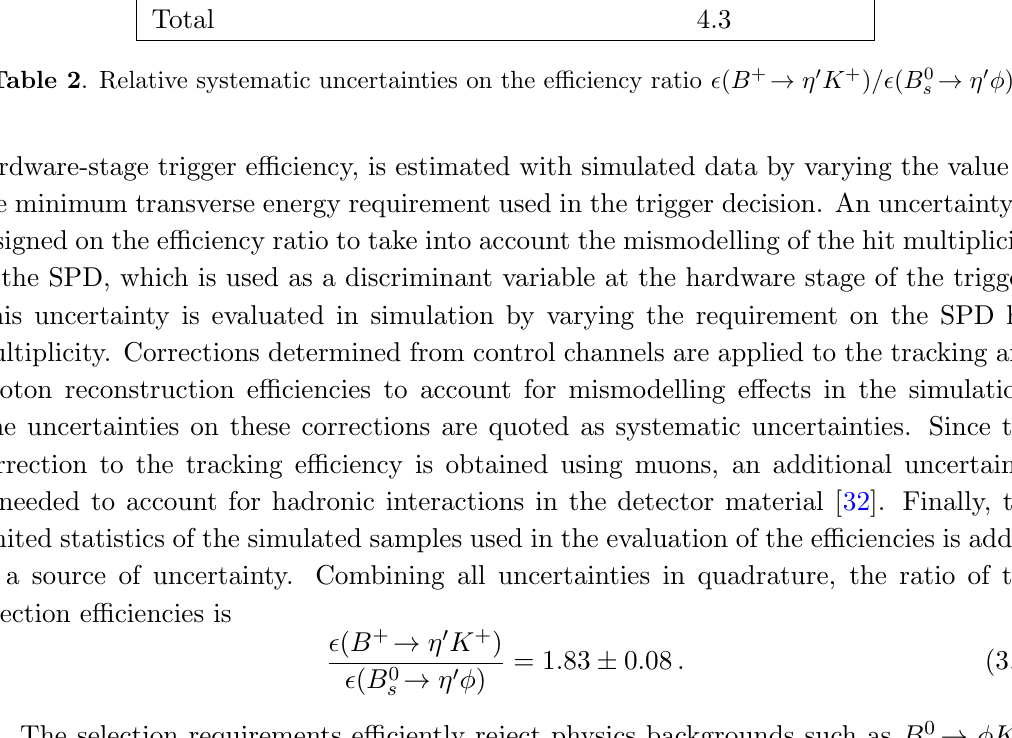
Table 2 . Relative systematic uncertainties on the e(cid:14)ciency ratio (cid:15) ( B +